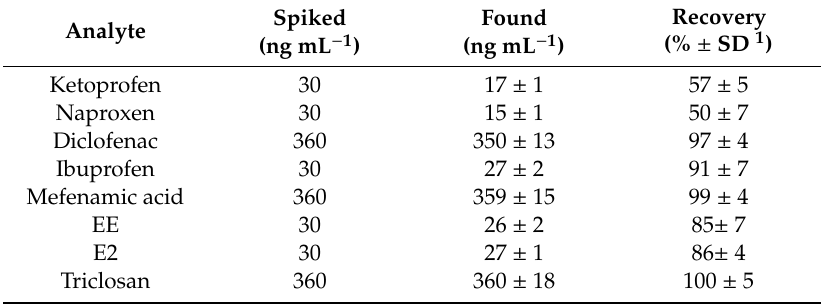
Table 2. Relative recovery study by SHS-HLLME for the extraction of emerging contaminants in wastewater. Recovery Spiked Found Analyte (% ± SD 1 ) (ng mL − 1 ) (ng mL − 1 ) Ketoprofen 30 17 ± 1 57 ± 5 Naproxen 30 15 ± 1 50 ± 7 Diclofenac 360 350 ± 13 97 ± 4 Ibuprofen 30 27 ± 2 360 86 ± 4 Triclosan 360 360 ± 18 100 ±